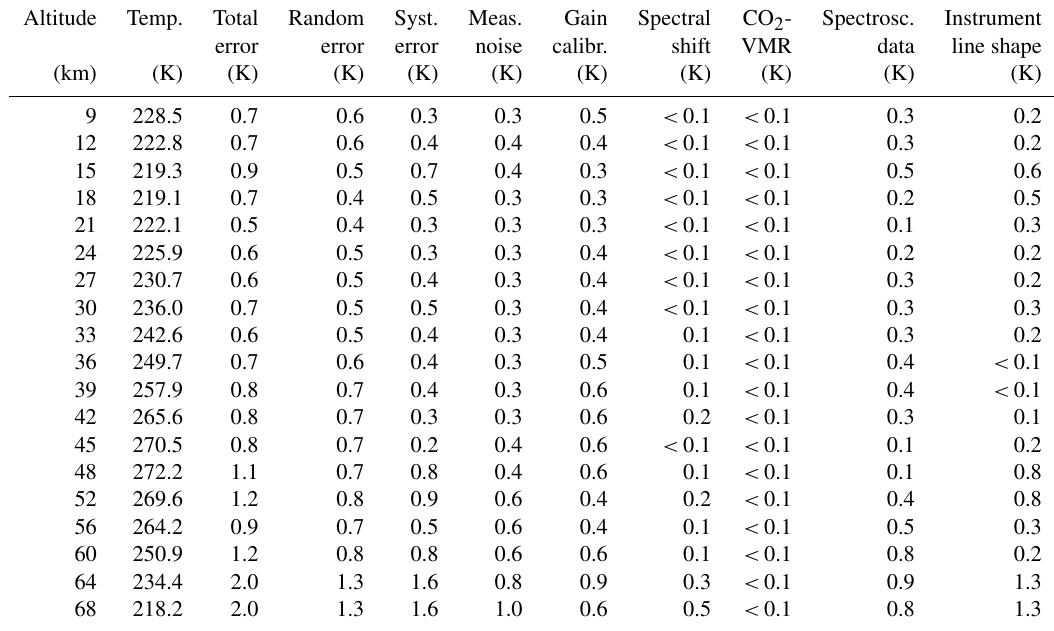
Table A8. FR data temperature error budget for southern midlatitude summer day. All uncertainties are 1 σ .